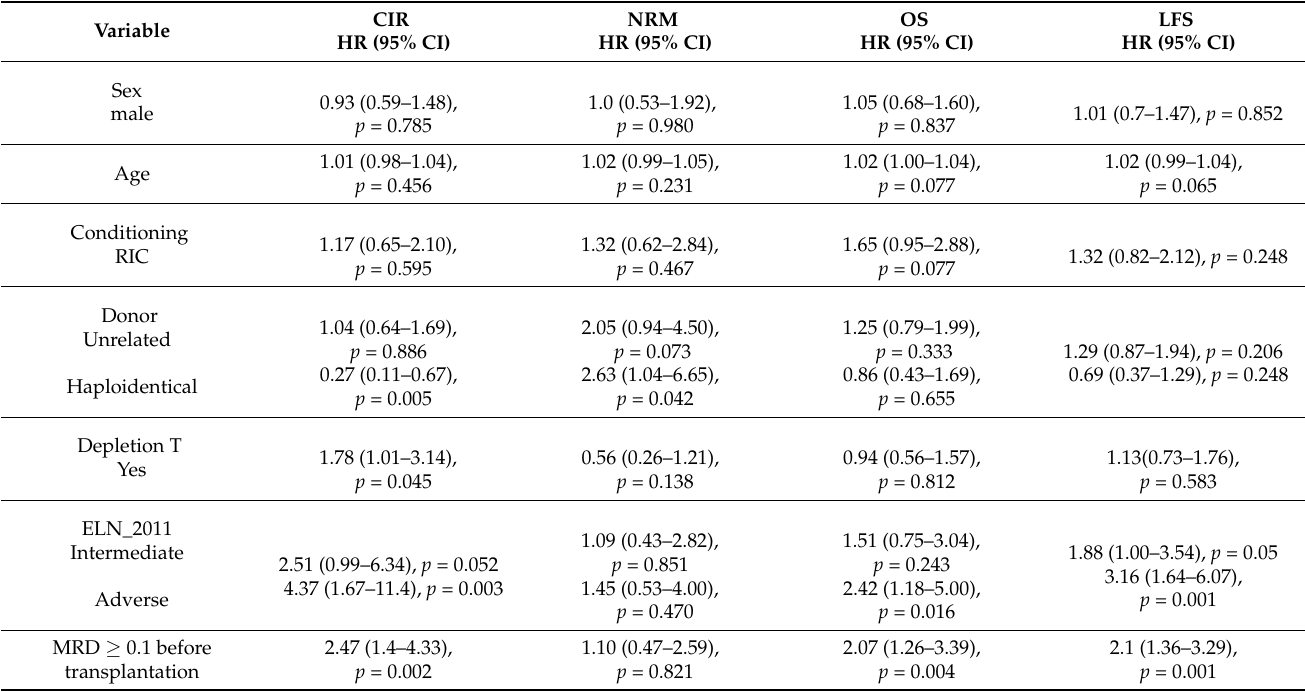
Table 3. Multivariate analysis considering MRD before